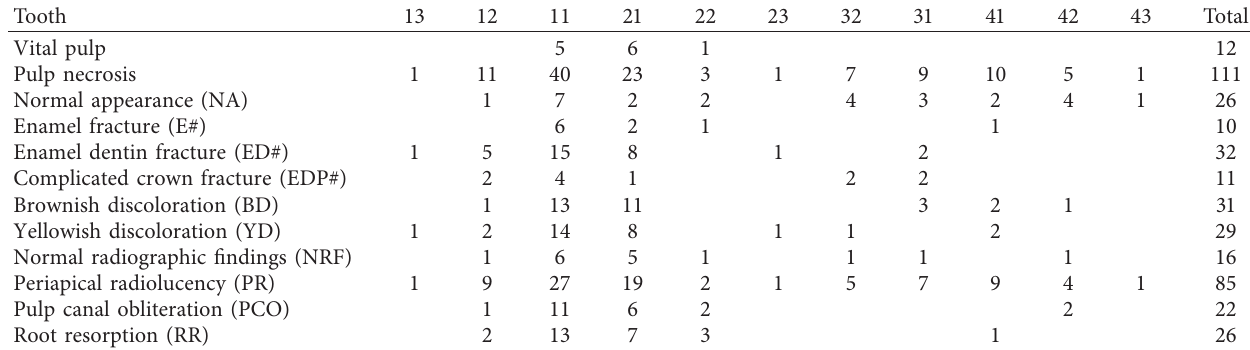
Table 3: Tooth distribution according to clinical and radiographic